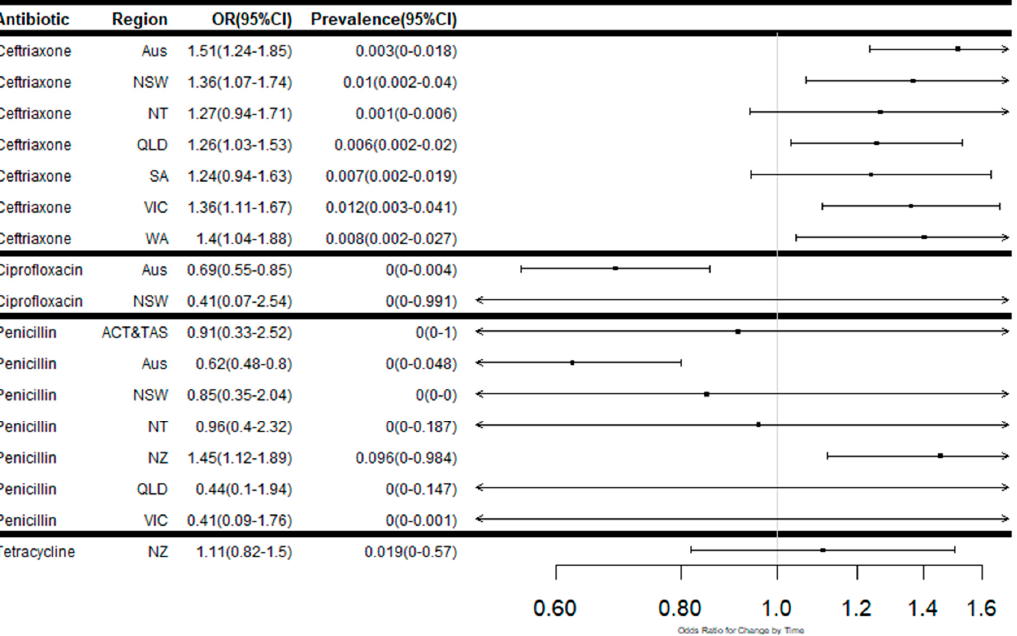
Figure 3. Meta-regression plots showing the odds ratios for changes in proportion and weighted average proportions of isolates with decreased susceptibility to each antibiotic over time in Australia, Australian states and territories and New Zealand.